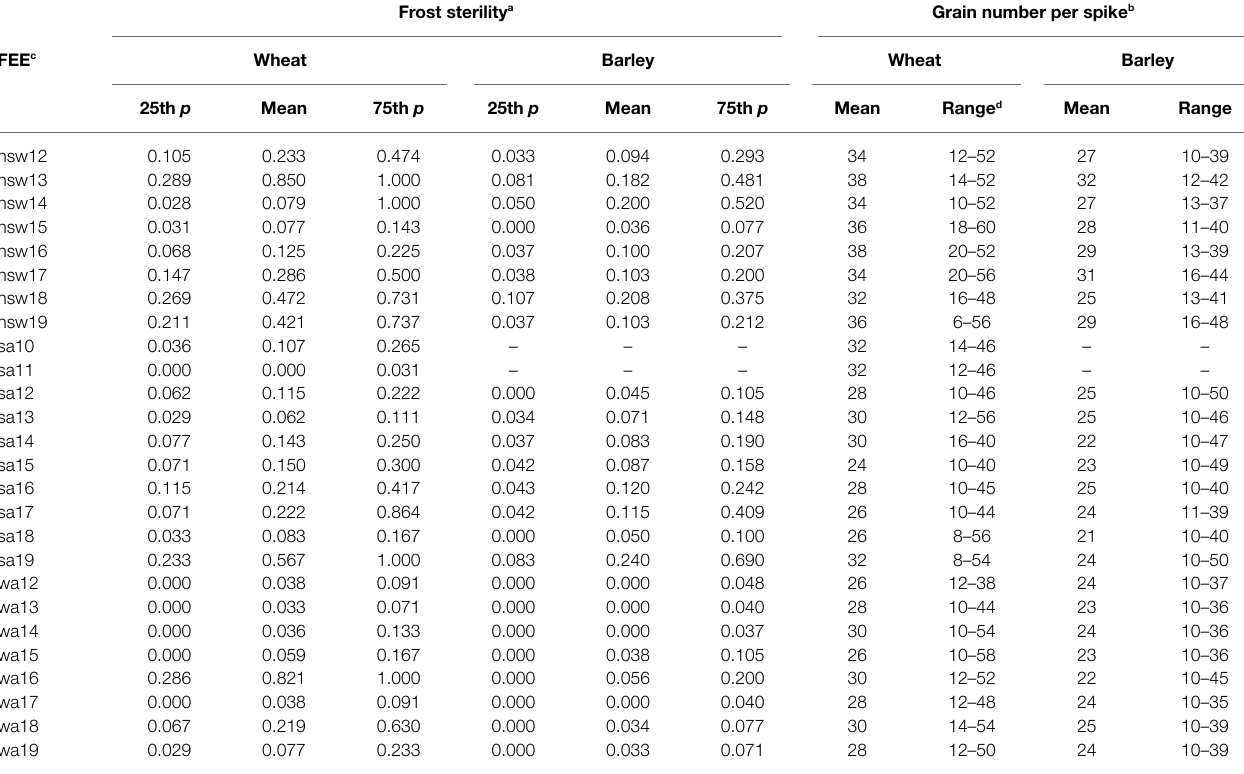
Frost sterility